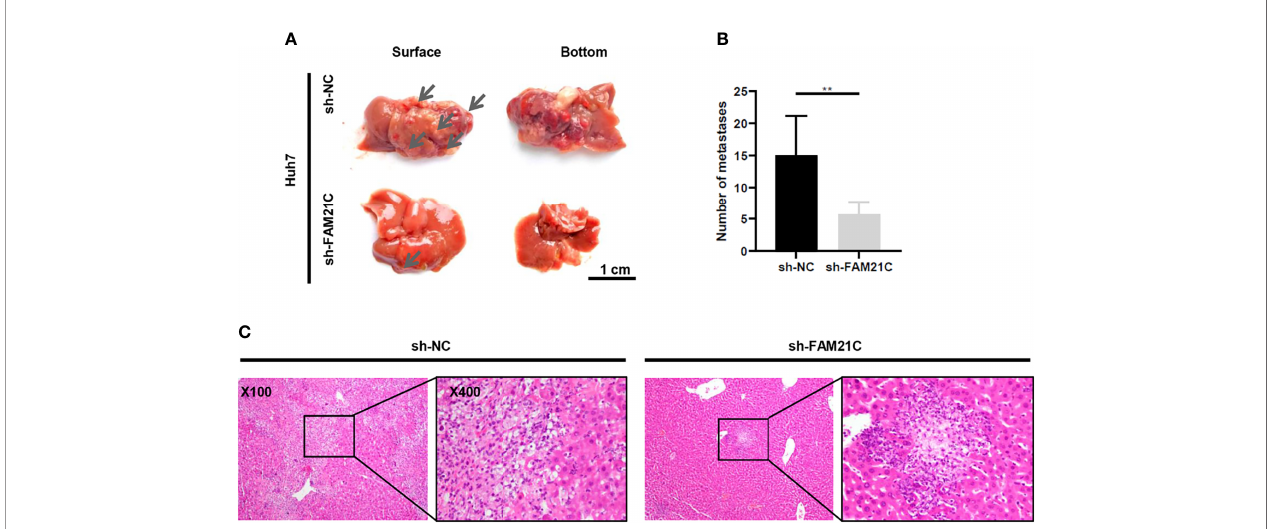
FIGURE 6 | FAM21C could promote HCC invasion and metastasis in vivo. (A) The metastatic tumor foci were widely distributed on the liver surface of the negative control group. The few metastatic lesions were localized predominantly on the liver lobe of the sh-FAM21C-expressing Huh7 group. Scale bar:1cm. (B) Histograms show the number of the metastatic tumor foci. Data are represented as the mean ± SD, n=6. ** P < 0.01. (C) Haematoxylin and eosin staining was performed on xenograft liver sections. Scale bar = 100× and